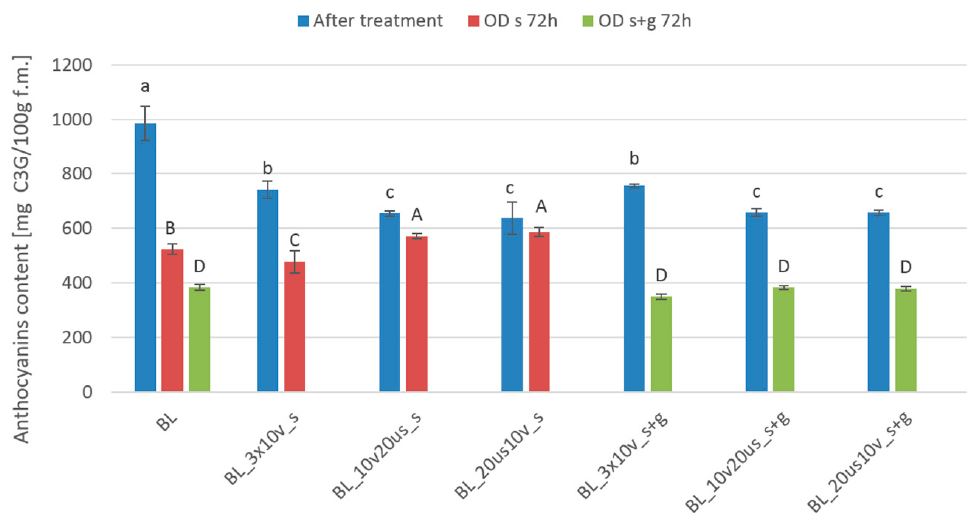
Figure 5. Anthocyanins content in di ff erent treated cranberries: Blanched (BL), reduced pressure (BL_3 × 10 v), reduced pressure with sonication treatment (BL_10 v 20 us), sonication treatment with reduced pressure (BL_20 us 10 v), and after osmotic dehydration (OD) in 61.5% sucrose solution (s) and in 30% sucrose solution with 0.1% addition of steviol glycosides (s + g). Di ff erent lowercase letters means significant di ff erence by the Duncan test ( p < 0.05) for samples after treatment, and di ff erent capital letters means significant di ff erence by the Duncan test ( p < 0.05) for samples after 72 h osmotic